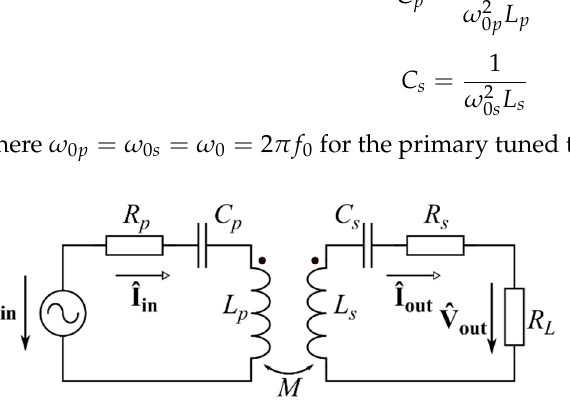
Figure 1. Equivalent AC circuit schematics for the series–series compensated IPT system.